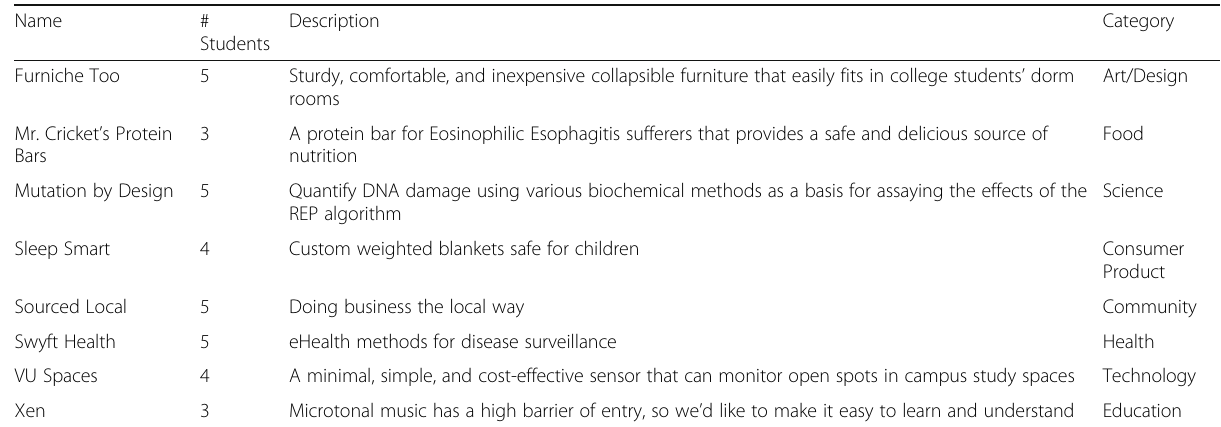
Table 2 Examples of student-created VIX teams